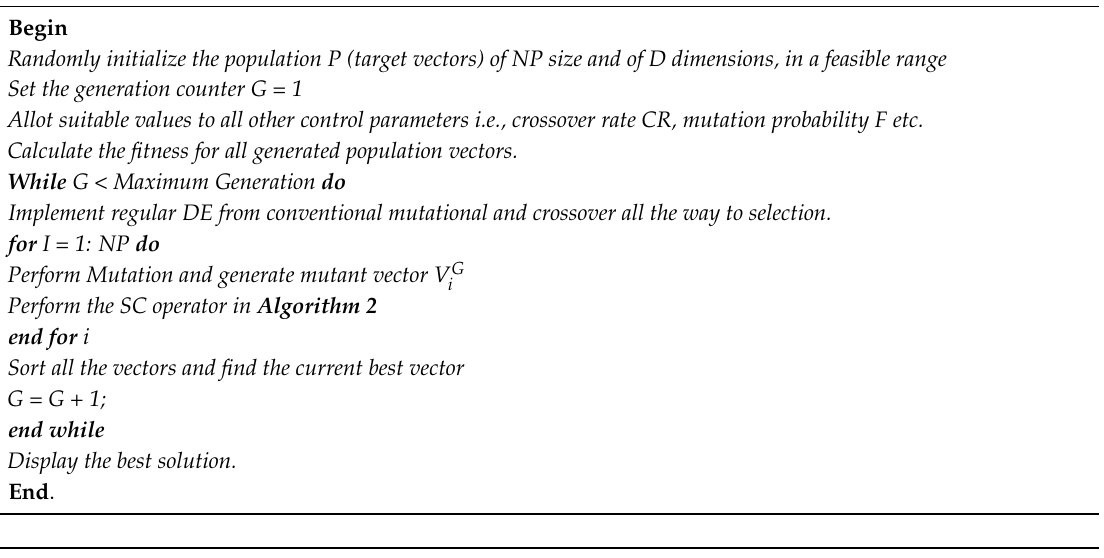
Algorithm 1: Stud Differential Evolution (SDE)